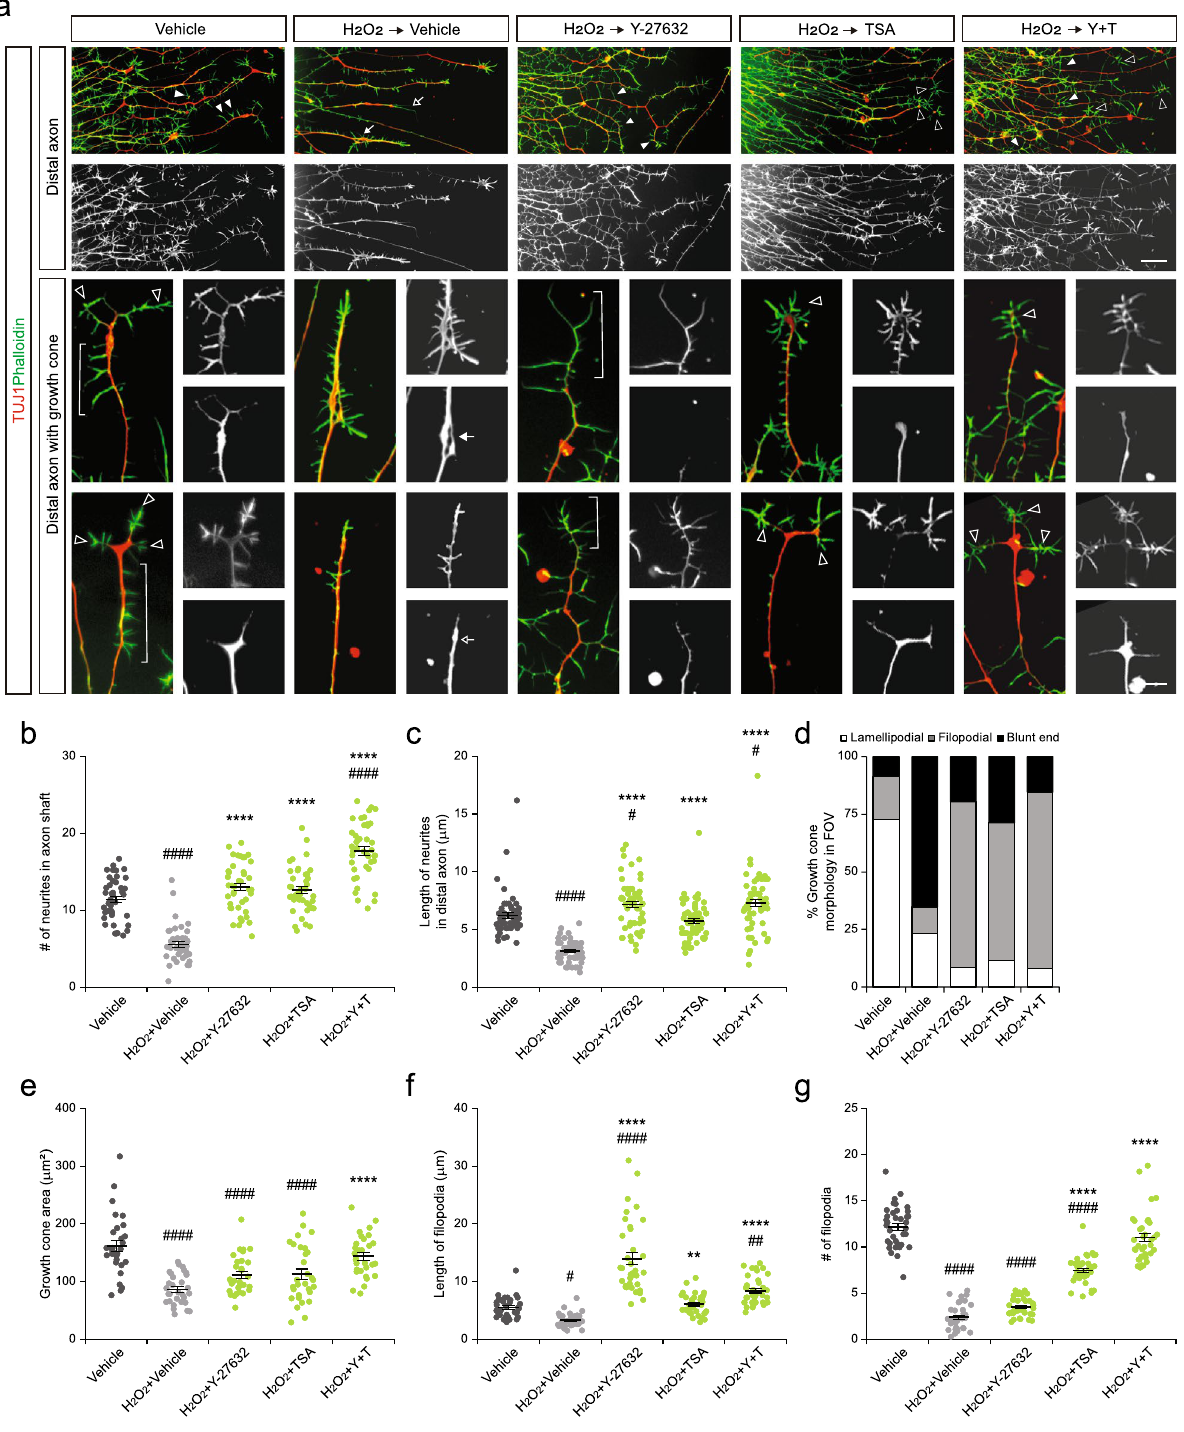
Figure 5. Assessment of regenerating growth cones after cytoskeletal drug treatment. ( a ) Representative images of distal axons and growth cones at the axon tips treated with cytoskeletal drugs. Note short neurites at the axon shaft (closed arrowheads) and diverse morphology of growth cones developing radially projecting filopodia (open arrowheads), elongated filopodia (brackets), disorganized and entangled microtubule network (arrow), or collapsed growth cone (open arrow). ( b , c ) The number and length of neurites at the axon shaft (n = 42 axons per condition in b, and n = 60 neurites per condition in c ). ( d ) Bar graph illustrating the ratio of growth cones with different morphology (n = 61–78 growth cones per condition). ( e – g ) The area of the growth cone ( e ) and the number ( f ) and average length ( g ) of neurites in distal axons (< 100 μm from the axon tip) (n = 30 growth cones per condition in e , n = 36 neurites per condition in f and g ). Error bars represent s.e.m.; # p < 0.05, ## p < 0.01, #### p < 0.0001 versus Vehicle; **p < 0.01, ****p < 0.0001 versus H 2 O 2 + Vehicle, one-way ANOVA test with Tukey’s test. Scale bars 20 μm (upper panels), 5 μm (lower